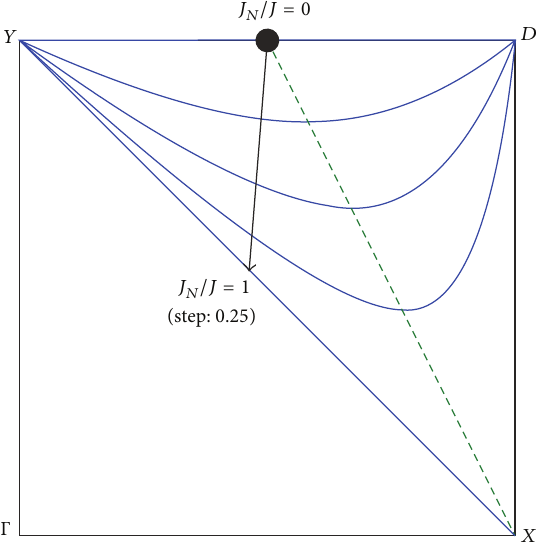
Figure 6: Two regions in the uniform zone for bcc(110) surface cut and ferromagnetic NNN interactions, with normal ( 𝑁 ) and reverse ( 𝑅 ) mode order in the spin-wave spectrum. The boundary between the regions shifts with growing |𝐽 𝑁 |/𝐽 as shown by the arrow. For no NNN interactions ( |𝐽 𝑁 |/𝐽 = 0 ) the reversal domain does not occur (its boundary amounts to the segment 𝐷 - 𝑌